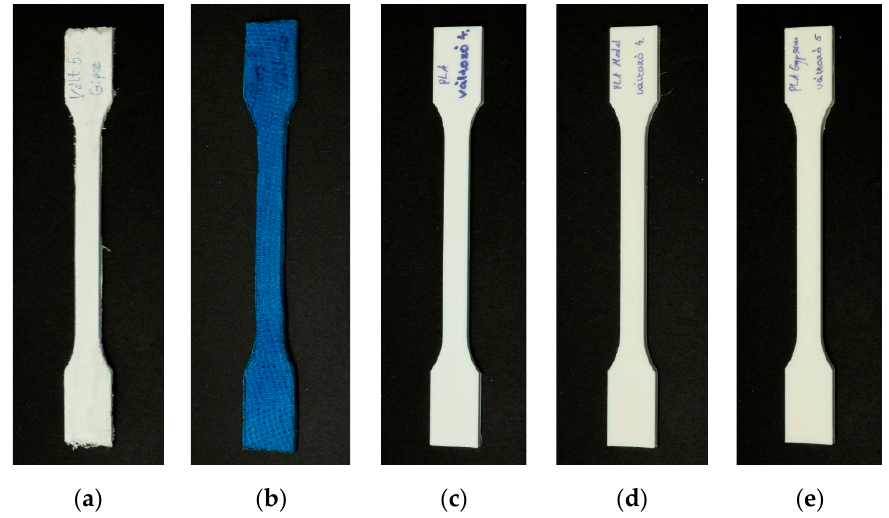
Figure 2. Tensile specimens of the materials ( a ) plaster (gypsum), ( b ) fiberglass, ( c ) PLA, ( d ) PLA Model, and ( e ) PLA Gypsum.